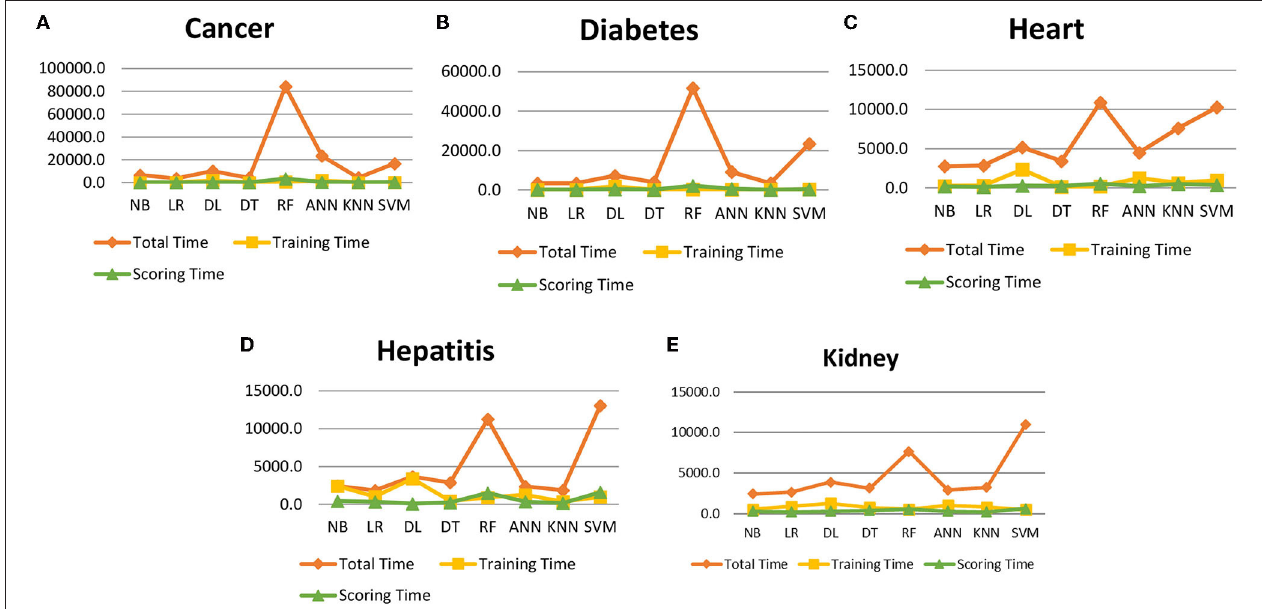
FIGURE 13 | Data processing time for cancer, diabetes, heart, hepatitis and kidney disease.